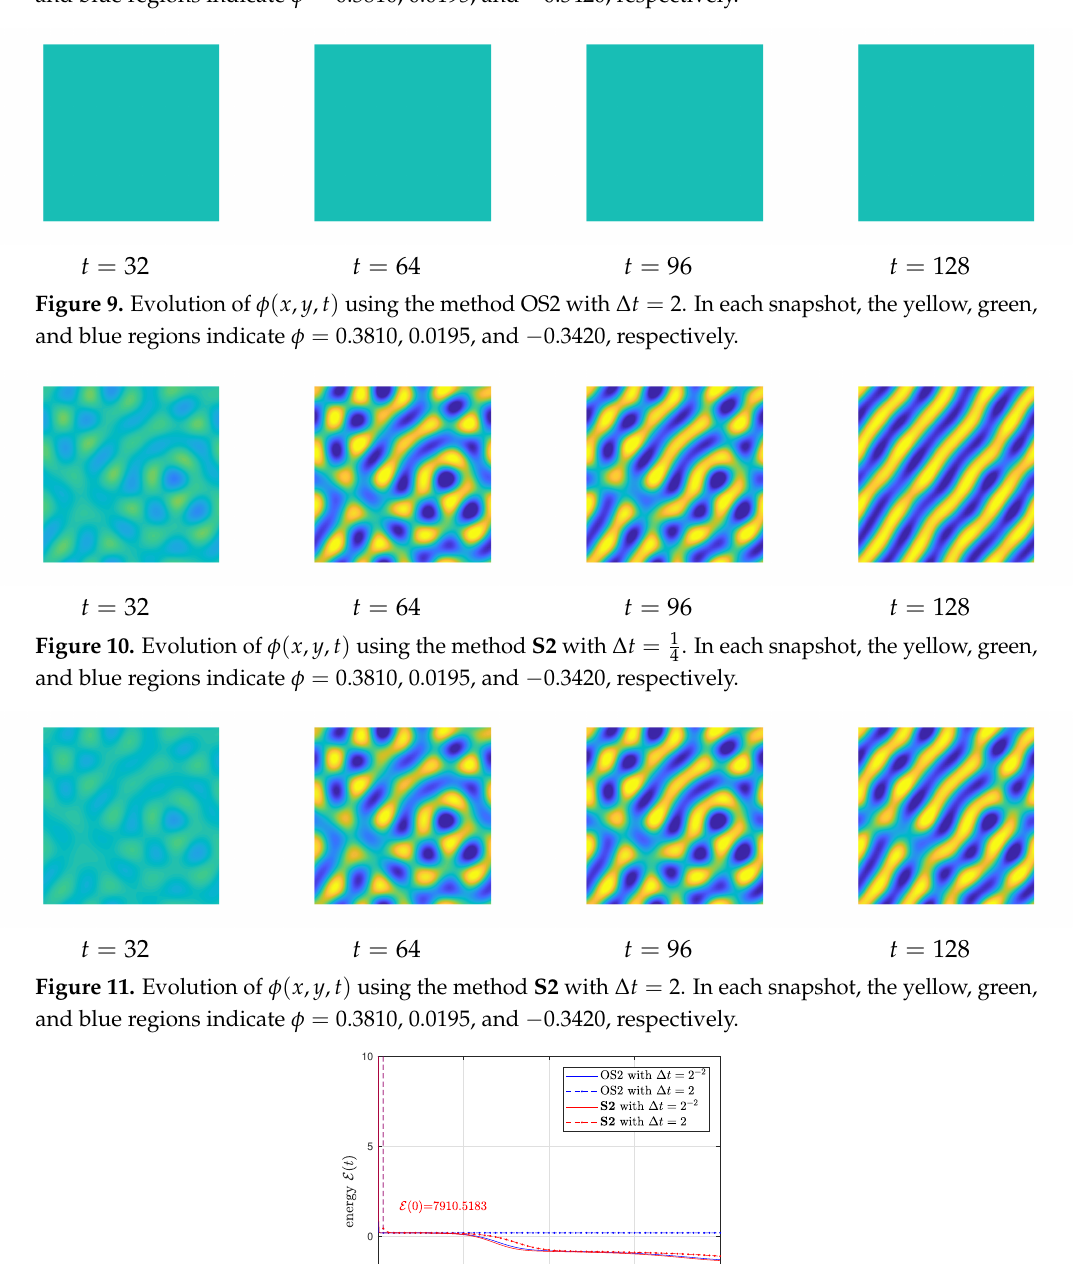
Figure 8. Evolution of φ ( x , y , t ) using the method OS2 with ∆ t = 1 and blue regions indicate φ = 0.3810, 0.0195, and